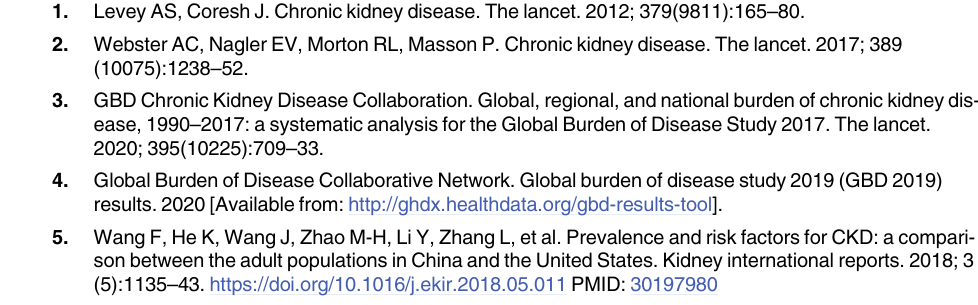
S6 Table. Odds ratio (95% CI) of factors associated with abnormal ACR ( � 30 mg/g) in CLHLS and NHANES. S7 Table. 1. Demographic characteristics and weighted mean (SD) of biomarkers (Chinese participants: CLHLS 2012). 2. Demographic characteristics and weighted mean (SD) of bio- markers (US participants: NHANES 2011–2014). S8 Table. Odds ratio (95% CI) of factors associated with CKD in Chinese and US popula- tion (weighted). S9 Table. Hazard ratio (95% CI) of CKD biomarkers on mortality in Chinese and US popu- lation